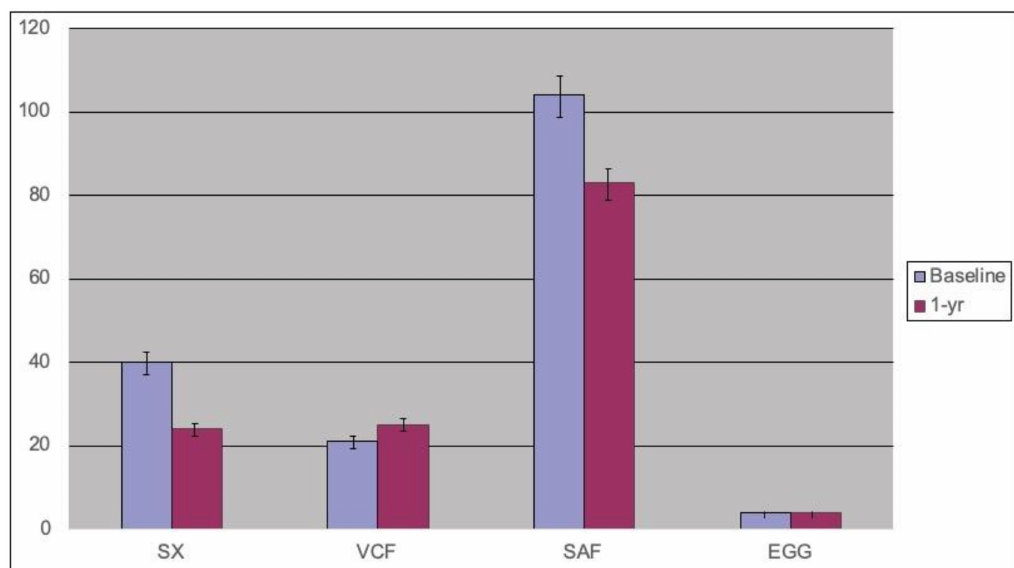
Figure 5. Autonomic e ff ect. Symptoms, autonomic and enteric measures at baseline and 1 year after gastric stimulation. Legends: SX: Symptoms; VCF: vagal cholinergic function; SAF: sympathetic adrenergic function; EGG: electrogastrography [23]. Upper GI symptoms (Sx) are scored on 0–10 scale for 5 common Gp Sx. Vagal cholinergic function (VCF) and sympathetic adrenergic function (SAF) are measured in standardized units. Electrogastrogram (EGG) frequency is reported in cycles per